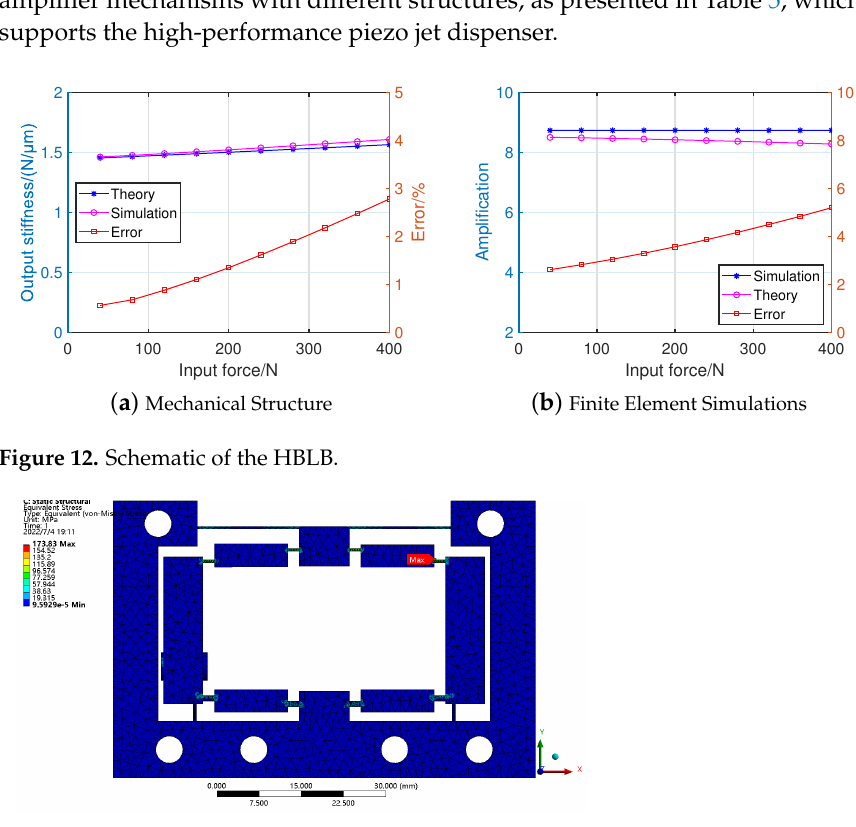
Figure 13. Stress distribution of the mechanism under the maximum input